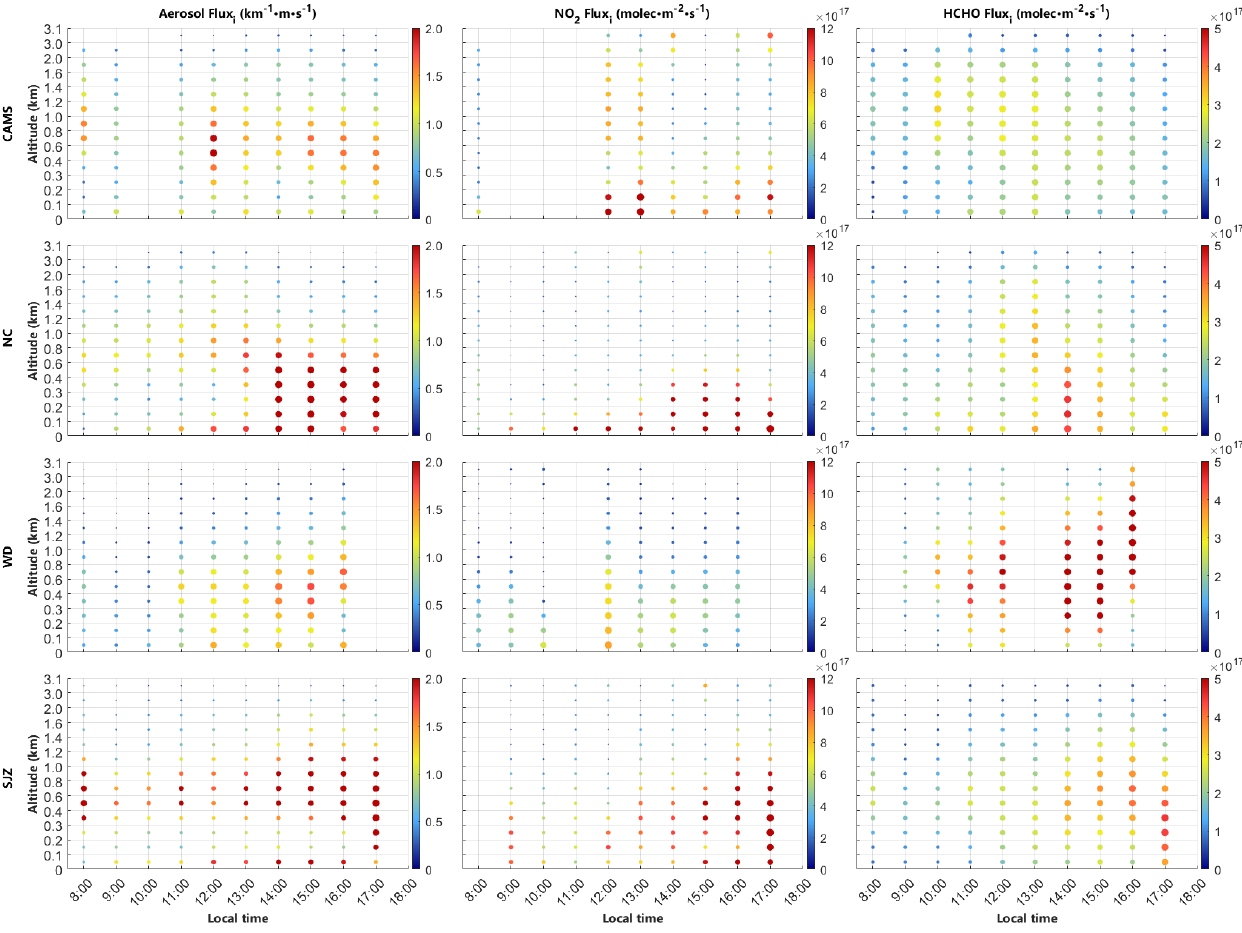
Figure 4. Transport flux at different altitudes (Flux i ) at CAMS, NC, WD, and SJZ stations on 5 February 2021.